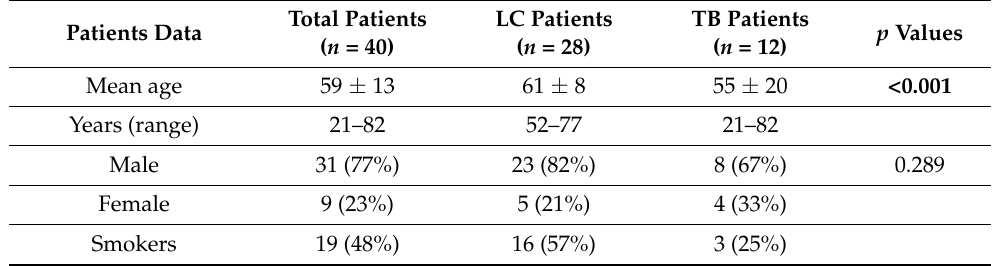
Table 1. Patients’ demographics, clinical records, and laboratory